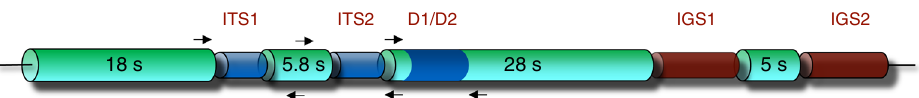
Fig. 2 DNA sequence encoding fungal ribosomal RNAs. The genes for fungal rRNAs are organized as a repeating unit. A single unit consists of the sequence encoding the 18S rRNA (for the small ribosomal subunit), internal transcribed spacer 1, sequence encoding the 5.8S rRNA, internal transcribed spacer 2, sequence encoding the 28S rRNA (for the large ribosomal subunit), intergenic sequence 1, sequence encoding the 5S rRNA, and intergenic sequence 2. The 18S, ITS1, 5.8S, ITS2, and 28S sequences are transcribed as a single RNA, which is then spliced to remove the ITS1 and ITS2 regions (blue cylinders) prior to assembly with the 5S rRNA into the complete ribosome consisting of the 18S, 5.8S, 28S, 5S (green cylinders) and assorted proteins. The ITS1 and ITS2 regions make up the ITS sequence, which is generally ~600bp in length although it can vary by more than 200bp. The D1/D2 region (blue shaded region on 28S) is similar in length. Both regions are informative with regard to sequence identi fi cation although the D1/D2 region is usually more conserved. Priming sites for PCR are shown as black arrowheads and can be used in various combinations. The 5S sequence is transcribed separately and is fl anked by the two IGS regions (brown cylinders), which can be very informative, however, they vary tremendously in size,